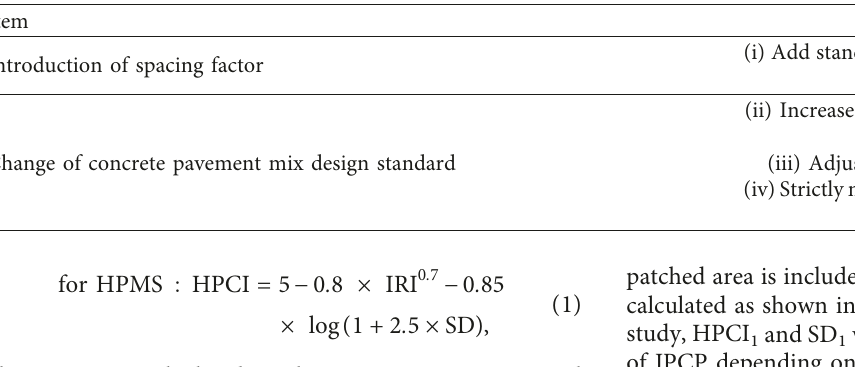
Table 2: Summary of Comprehensive Plan to Improve Concrete Pavement Quality (2010).